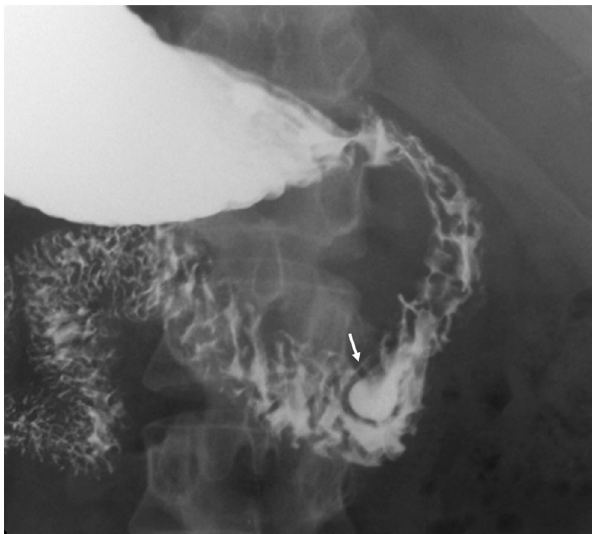
Fig. 5 Intraduodenal diverticulum in a 58-year-old woman. Single- contrast upper gastrointestinal study in the right anterior oblique projection shows a well-defined oval lesion (arrow) surrounded by a radiotransparent halo ( “ windsock ” sign). The lesion contains oral contrast material and projects into the true duodenal